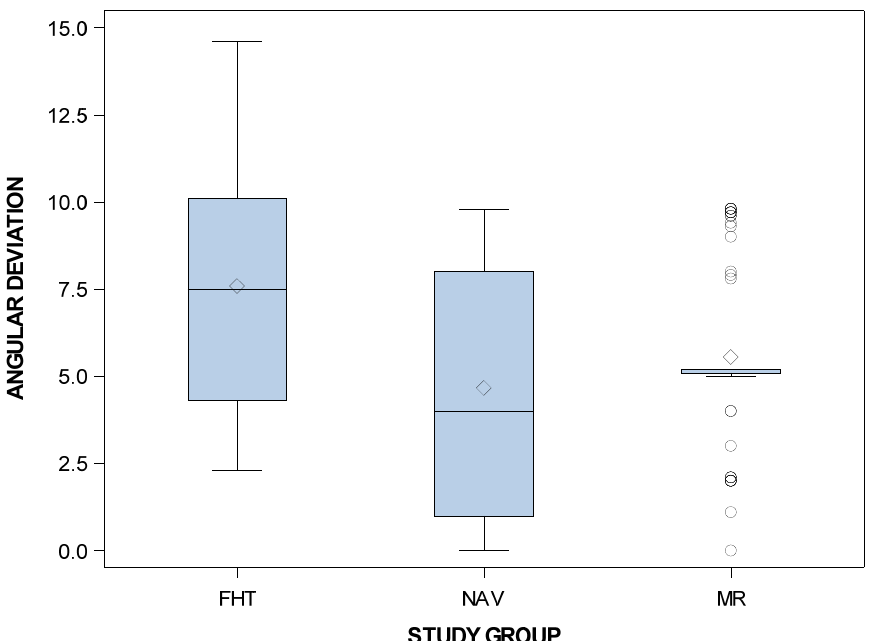
Figure 11. Box plot of angular deviations in planned and placed orthodontic micro-screws between the computer-aided static navigation technique, mixed reality technique and conventional freehand technique study groups.